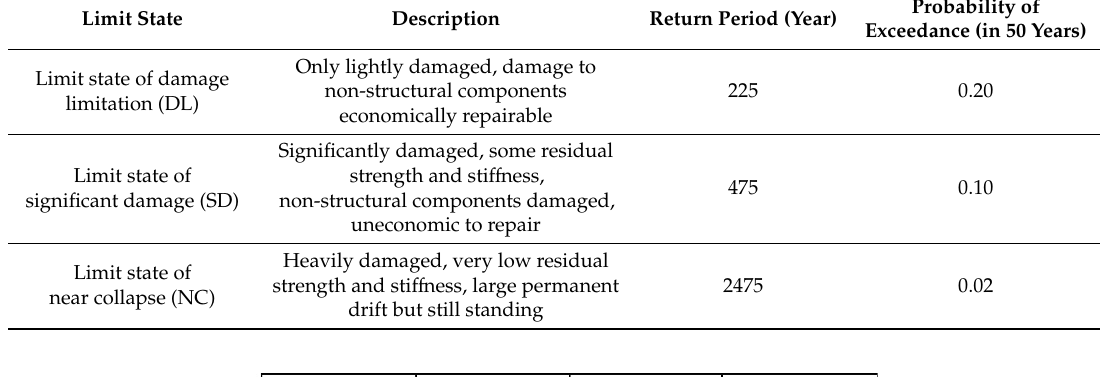
Table 7. Limit states in Eurocode-8 (Part 3) [86,87].